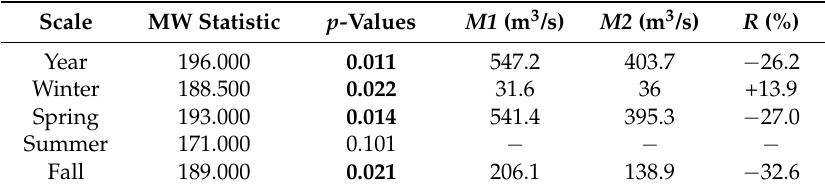
Table 4. Comparison of mean values of annual and seasonal maximum daily flows before (1980–2002) and after (2004–2014) construction of the diversion dam using the Kruskal-Wallis test. Monitoring method. p- Values M1 (m 3 /s)